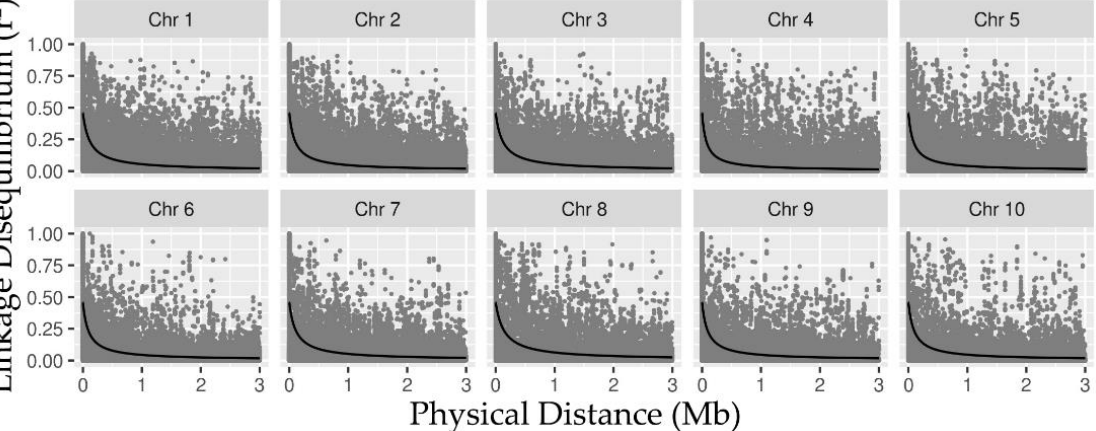
Figure 2. Decay of linkage disequilibrium (LD) of all SNPs (10.507) in the ten chromosomes estimated by r 2 (y-axis) along with physical distance in Mb (x-axis).